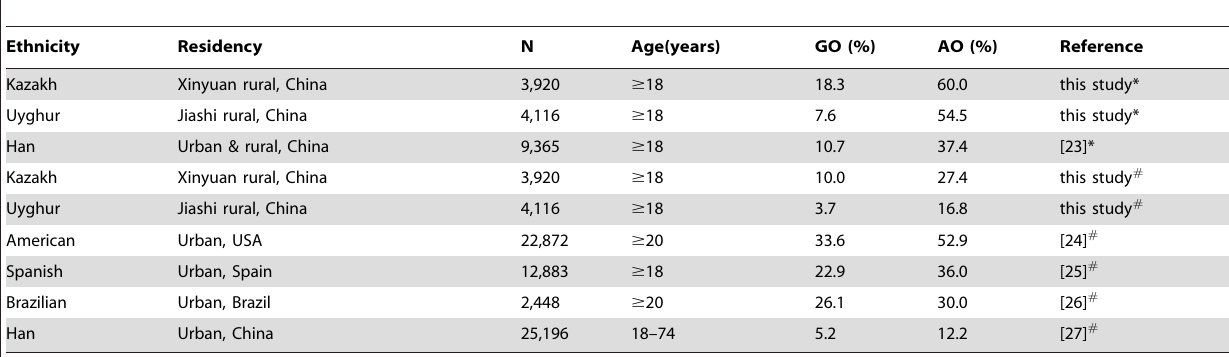
Table 4. A comparison of general obesity and abdominal obesity from selected ethnic groups within China and in the world.